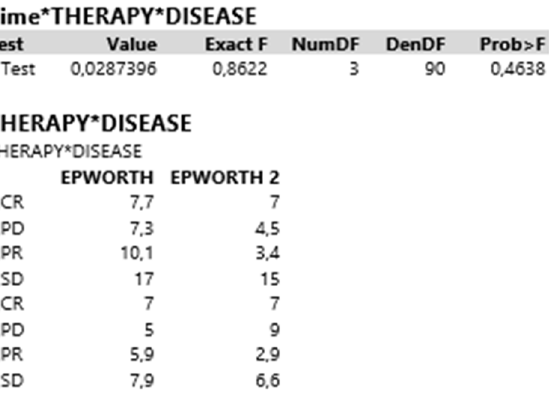
Figure 3. Triple interaction time*therapy*disease appeared to have an insignificant effect on Ep- worth responses ( p = 0.464).